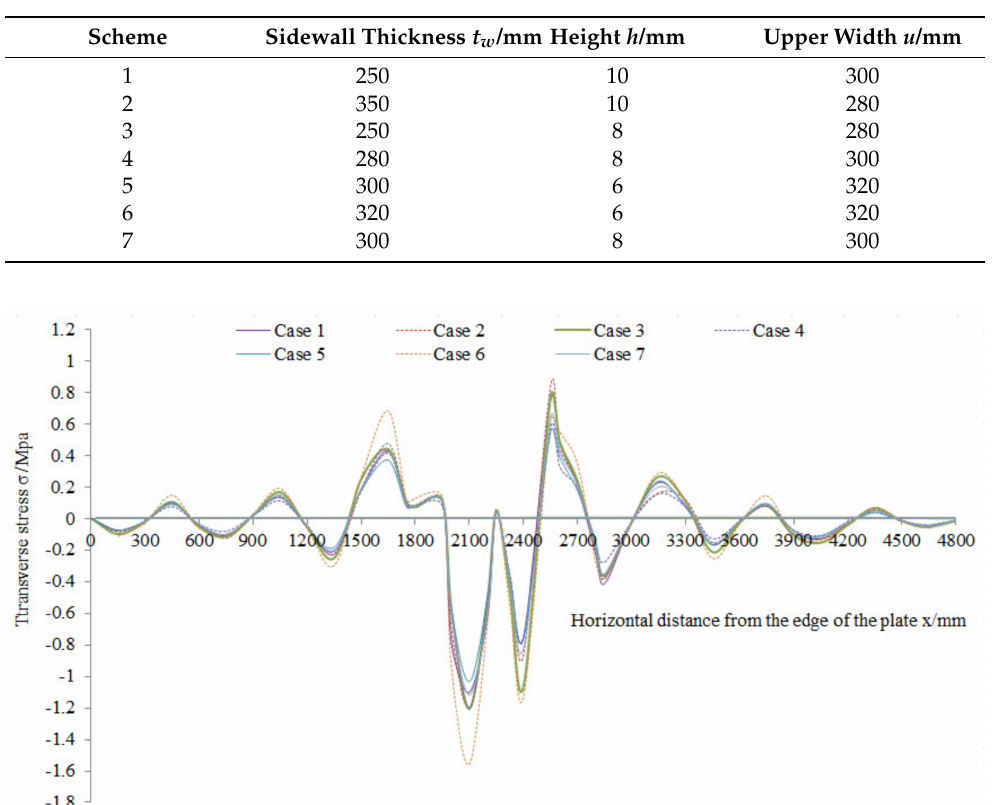
Figure 10. Comparison of the transverse tensile stress distribution of the pavement under different schemes under load II.